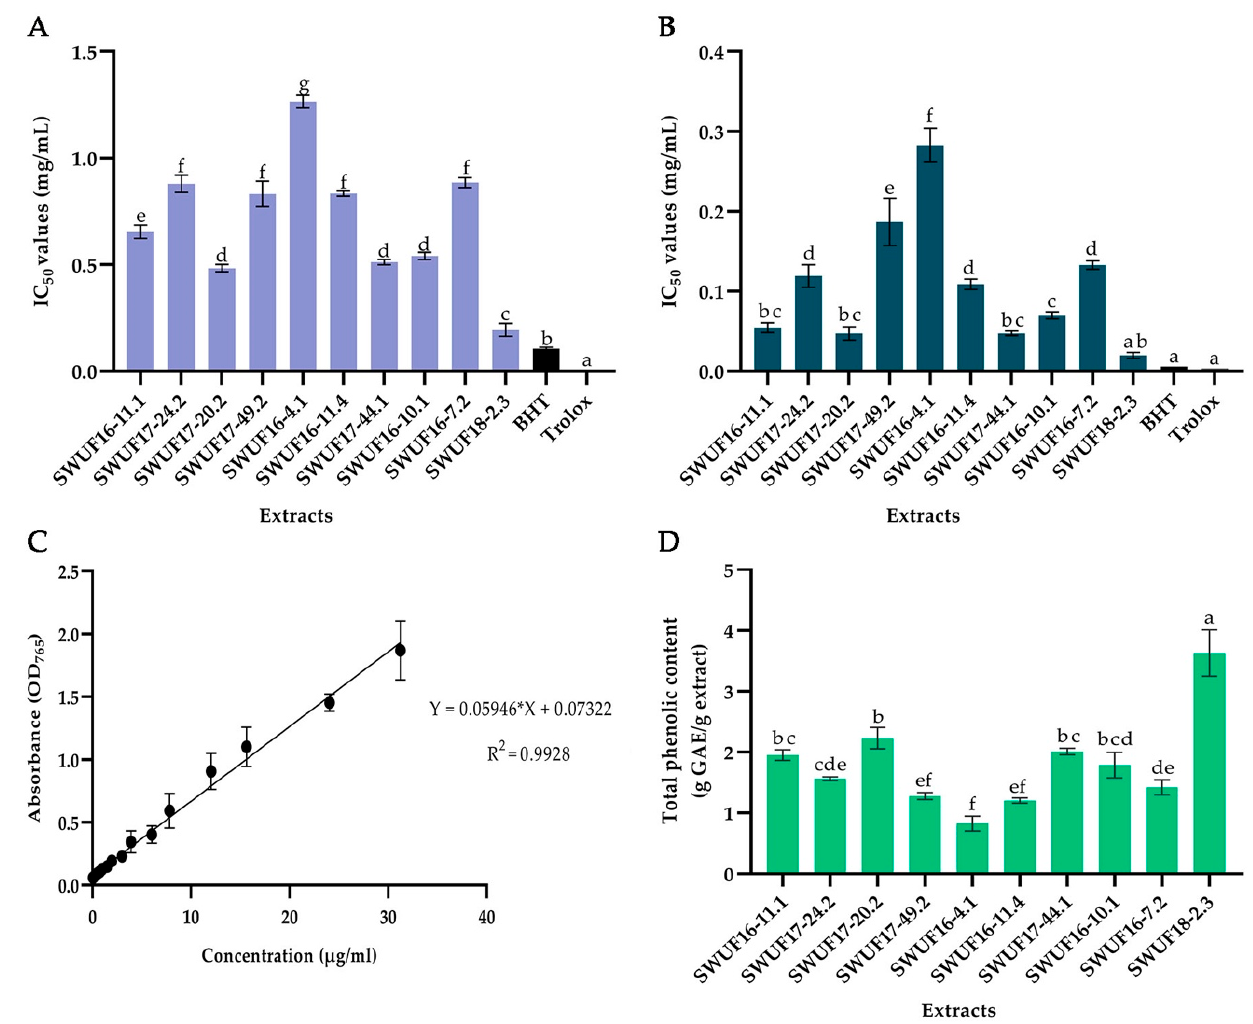
Figure 2. IC 50 values of antioxidant activities, DPPH and ABTS radical scavenging and total phenolic content of ethyl acetate extracts of Xylaria spp. and standard BHT and Trolox. ( A ) DPPH assay. ( B ) ABTS assay. ( C ) standard curve of gallic acid. ( D ) total phenolic content. Data expressed as means ± standard deviation. Means within each graph with different letters (a–g) differ significantly ( p < 0.05).